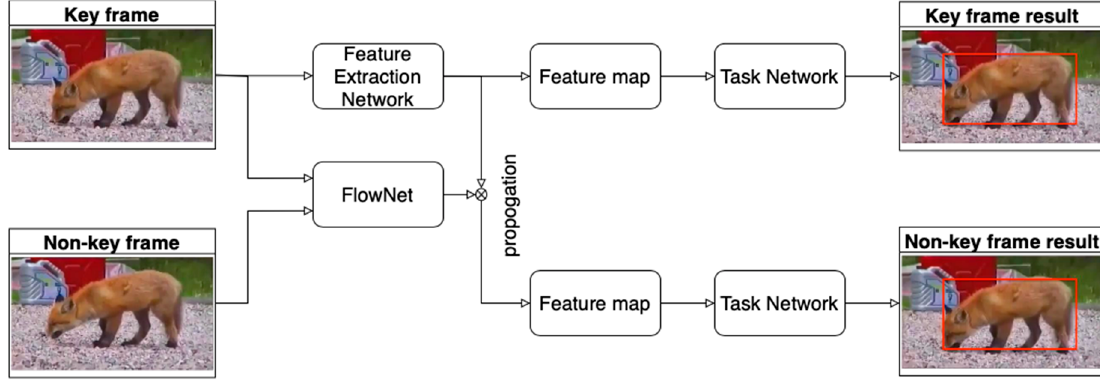
Figure 3. DFF (deep feature flow) framework [28].